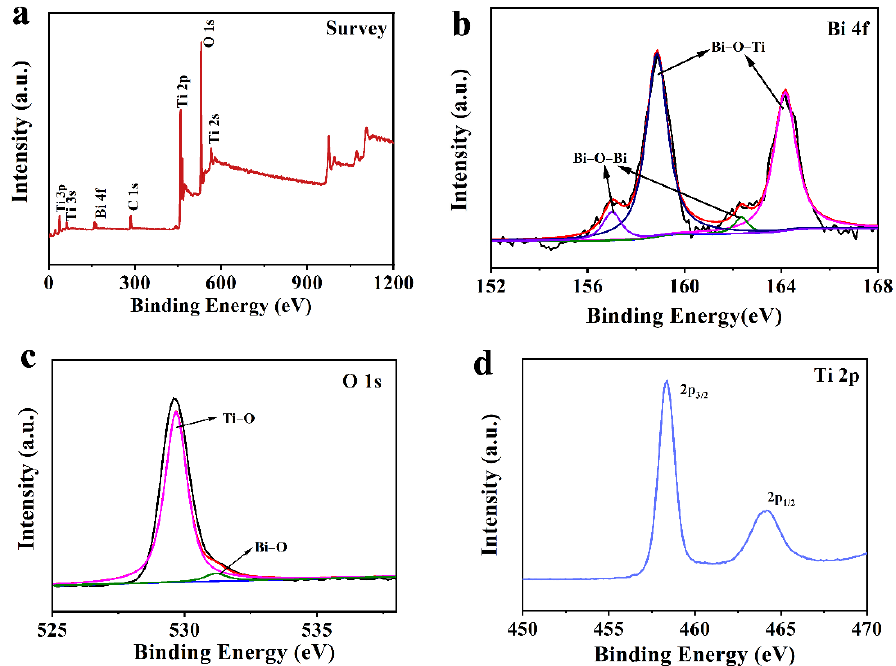
Figure 2. XPS patterns of BT-3 ( a ) survey spectrum; ( b ) Bi 4f spectrum; ( c ) O 1s Spectrum; ( d ) Ti 2p spectrum.